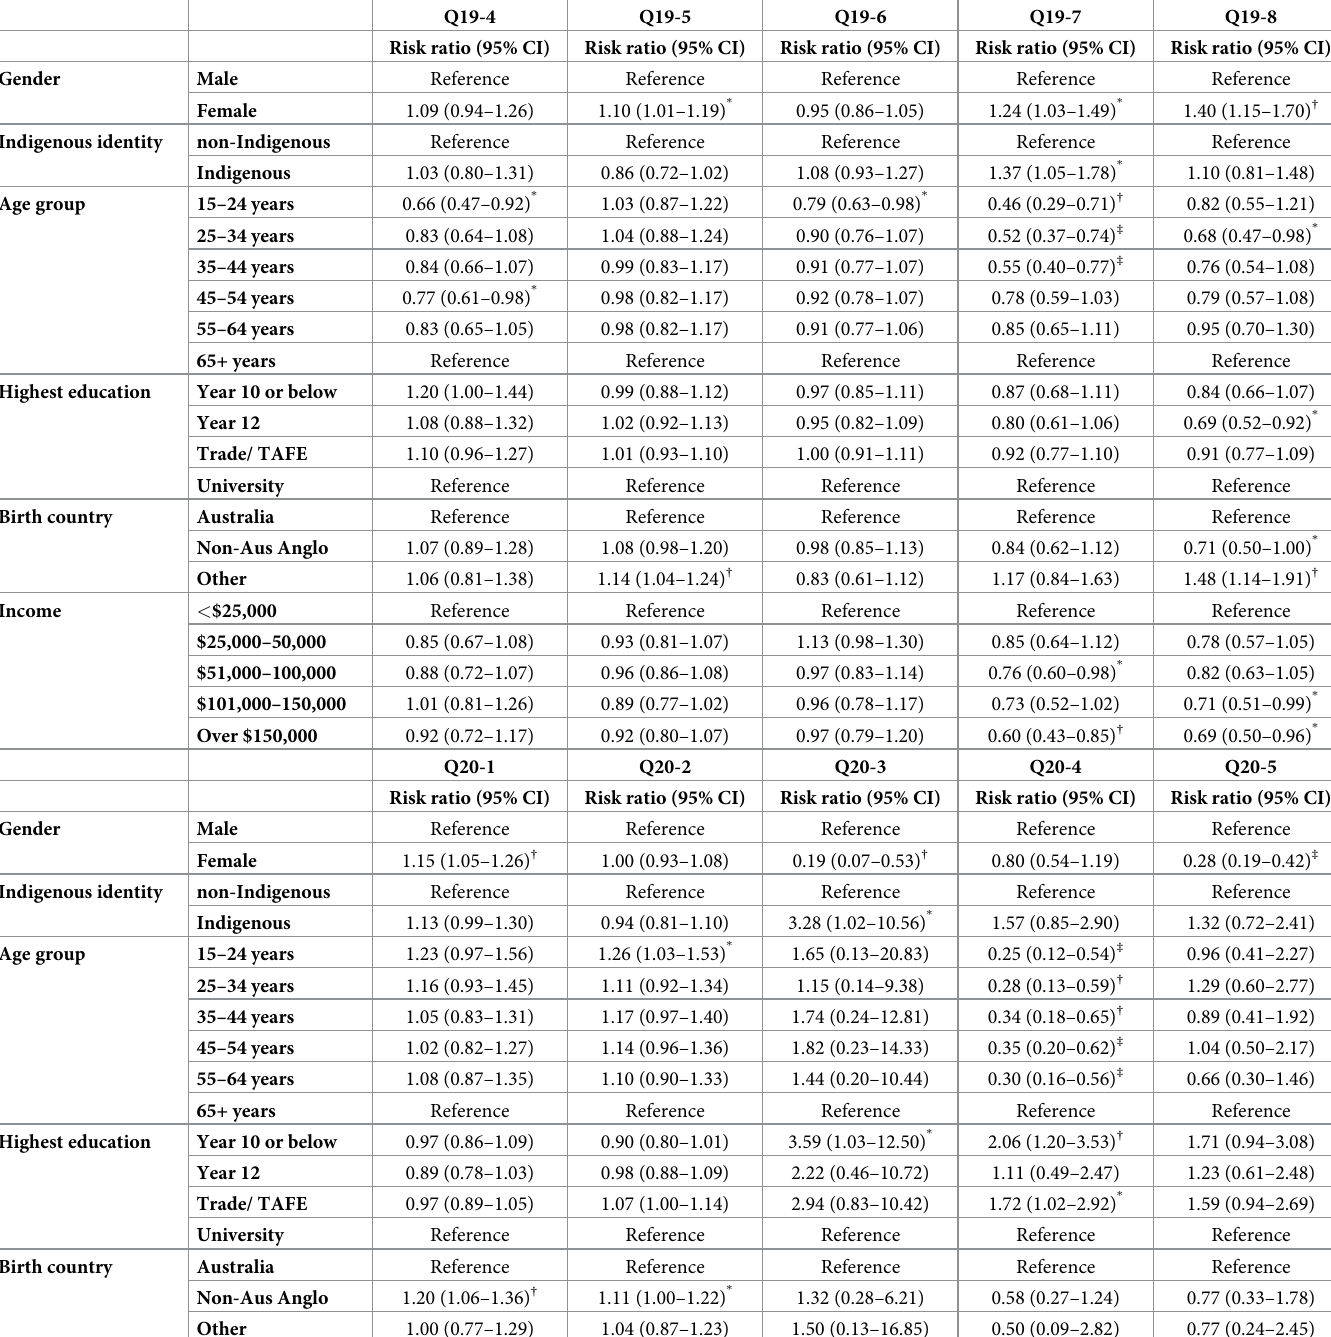
Table 4. Independent socio-demographic predictors of responses to individual items without adequate factor loading *